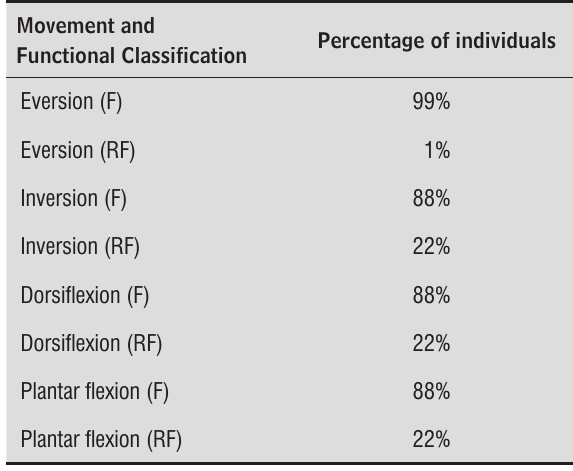
Table 2 - Alterations observed in the inspection of the